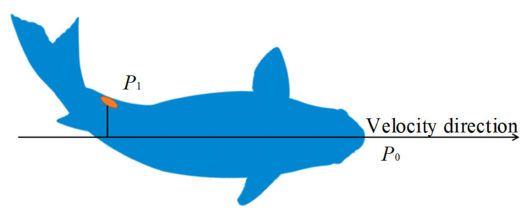
Figure 22. Fish swimming diagram.